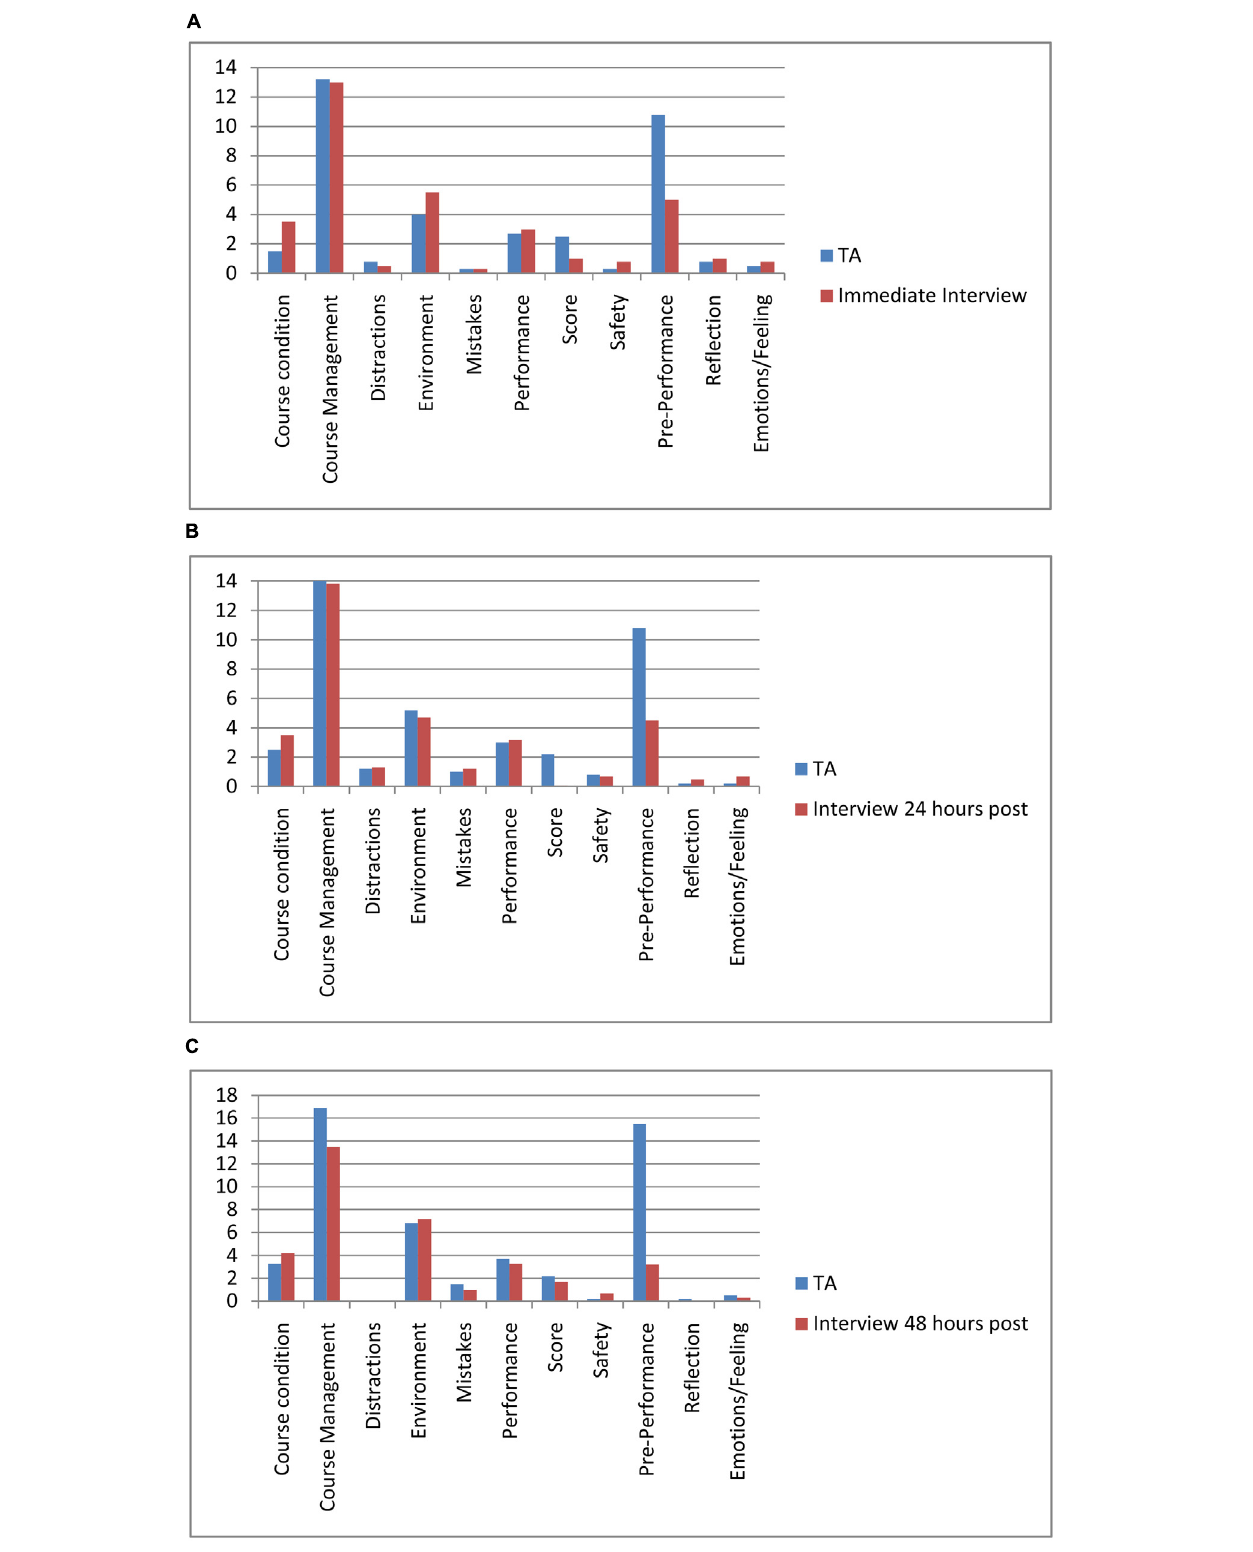
FIGURE 1 | Mean frequency of second-order themes that were cited during Think Aloud (TA; during performance) and interviews; (A) 10 min post performance (B) 24 h post-performance (C) 48 h post performance.